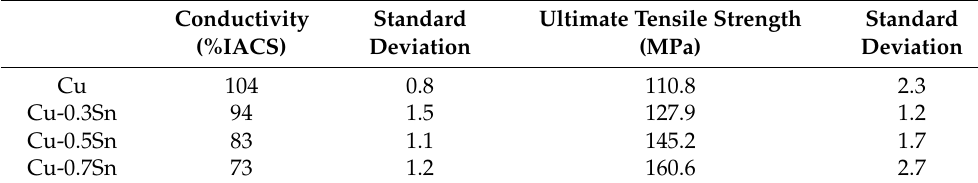
Figure 4. The stress–strain curves of Cu alloys with different Sn contents.